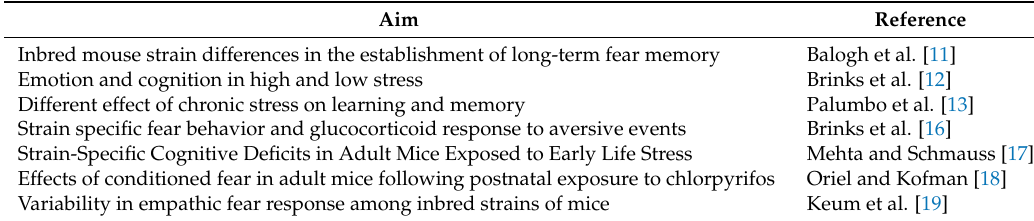
Table 1. Previous studies comparing C57BL/6 and BALB/c mice strain in relation to differences in behavioral